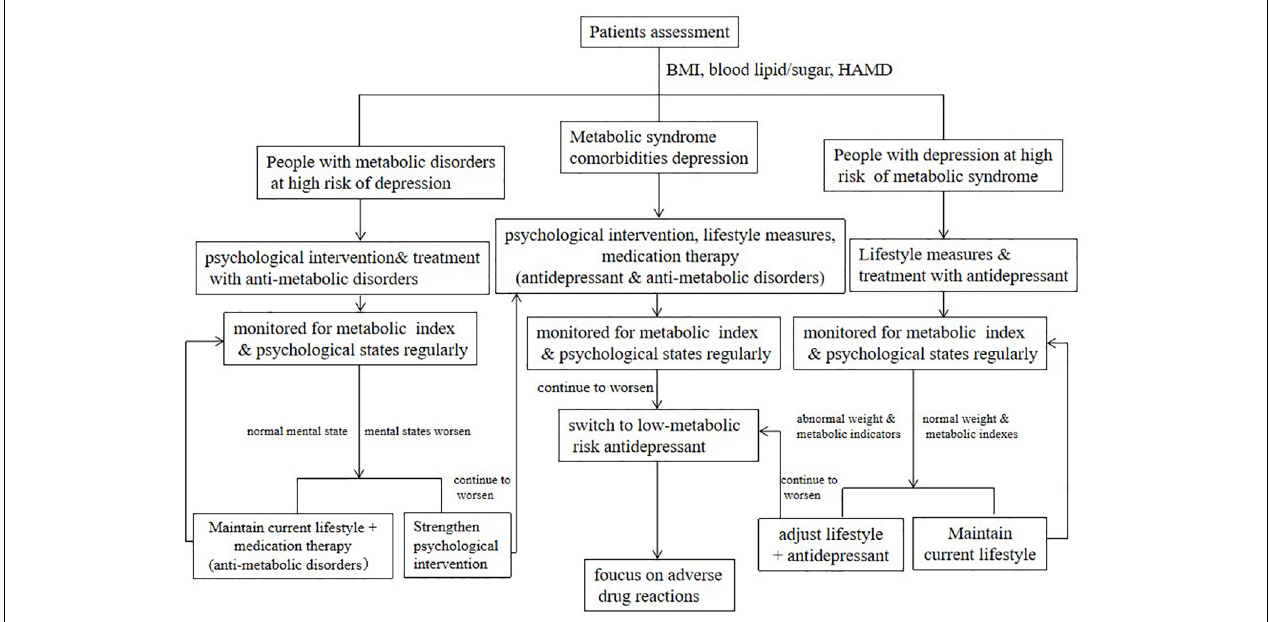
FIGURE 1 | Flowchart of clinical management of metabolic disorders comorbidity with